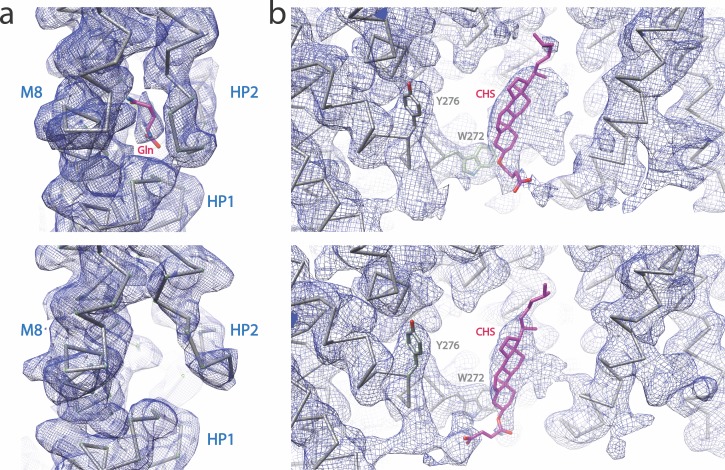
Cryo-EM densities of the substrate and putative CHS binding sites of SLC1A5, at the contour level 6σ.(a) Cryo-EM densities of the substrate-binding site with (upper panel) or without (lower panel) Gln substrate. (b) Cryo-EM densities of the putative CHS binding site with (upper panel) or without (lower panel) Gln substrate. The backbone of the models is shown. The Gln substrate and CHS are shown as sticks. The side chains of Y276 and W272 are shown as a reference.